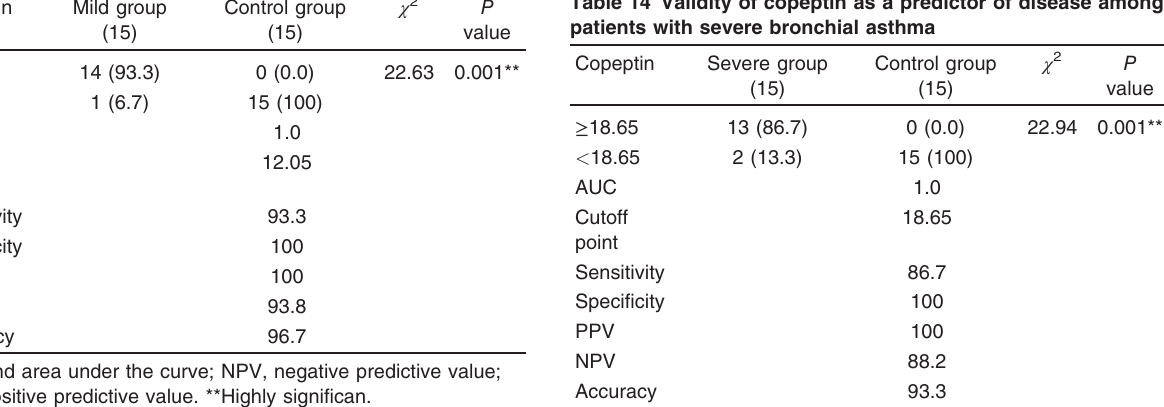
Table 12 Validity of copeptin as a predictor of disease severity among patients with mild bronchial asthma Copeptin